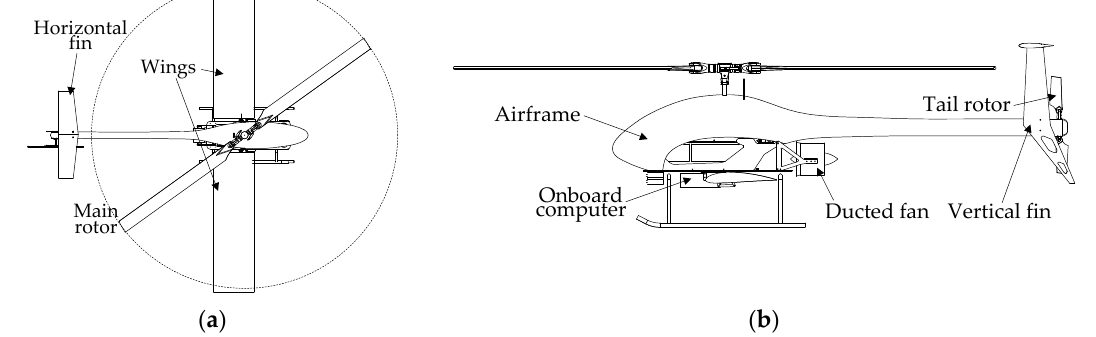
Figure 2. Diagram of SCH Configuration WDH. ( a ) Top view; ( b ) Side view.